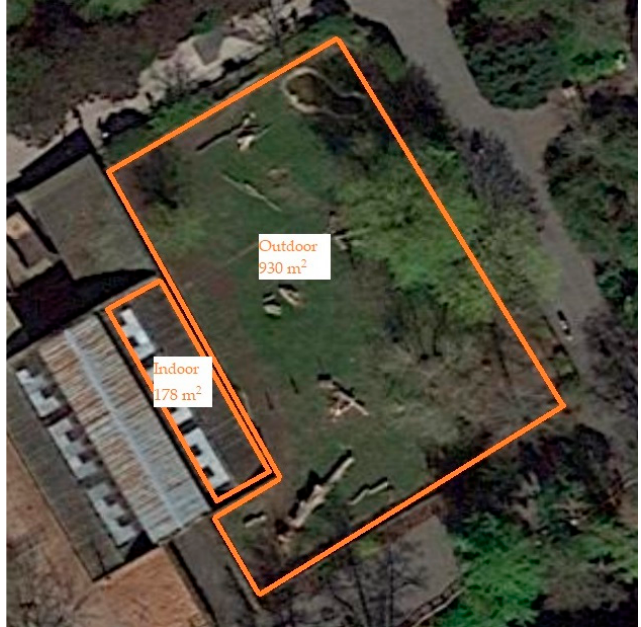
Figure A7. Enclosure plan for Malayan tapir ( Tapirus indicus ) in the ‘ Cattle House ’ exhibit. Orange lines signify approximate areas accessed by individual animals with dimensions of total available space. Copyright: Google Earth.